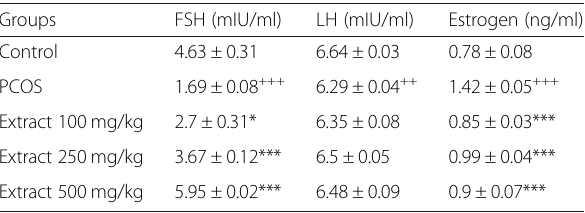
Table 1 Mean hormone concentrations in different